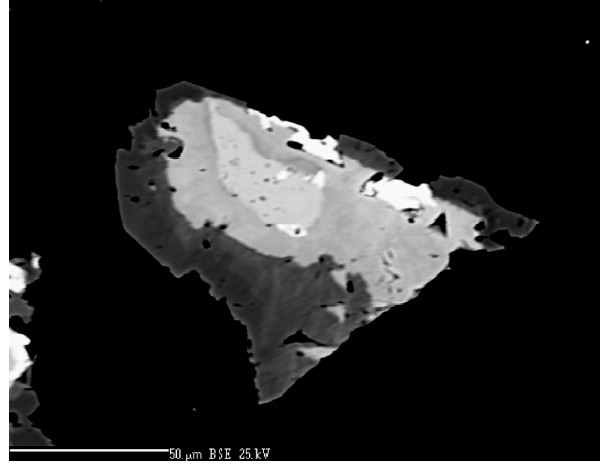
Figure 62. The core of the zonal aggregate is formed by new Hg-Cu-Sb selenide (light grey), overgrown by Hg-hakite (grey) with the tetrahedrite (dark grey) rim. Tiemannite (white) in the form of anhedral grains is the oldest phase in the association. BSE photo. P ř íbram, a dump of shaft 16. Photo by J. Sejkora and P. Škácha.